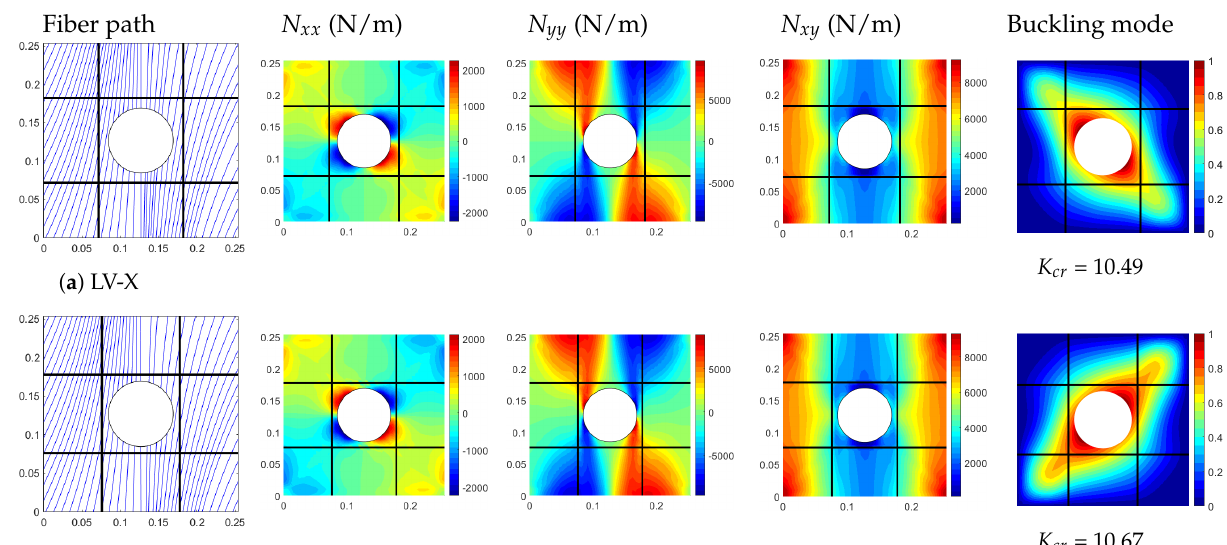
Figure 17. Comparison of optimal fiber paths, stress resultants, and buckling modes for different study cases of stiffened plate under in-plane shear displacements considering AFP manufactur-